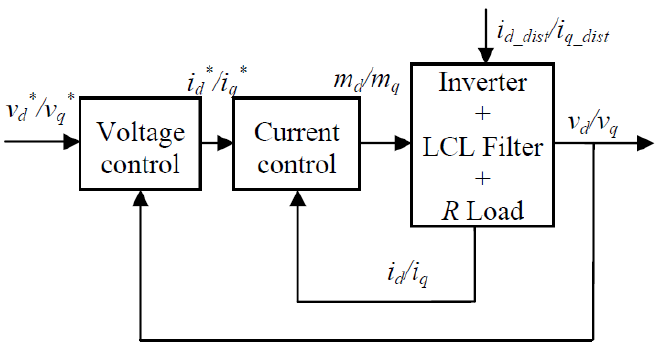
Figure 4. Controllers structure in the dq reference